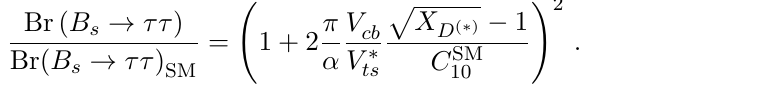
Figure 2 . Left: allowed regions by R ( D ) and R ( D (cid:3) ) in the (cid:21) L the weighted average for R ( D ( (cid:3) ) ) EXP =R ( D ( (cid:3) ) ) SM . Note that already small couplings are su(cid:14)cient to account for R ( D ) and R ( D (cid:3) ). Therefore, the bounds from LHC searches are weakened and the leptoquarks can also be easily heavier than 1 TeV and still explain the anomalies with couplings in the perturbative regime. Right: prediction for B s Here we neglected small CKM suppressed